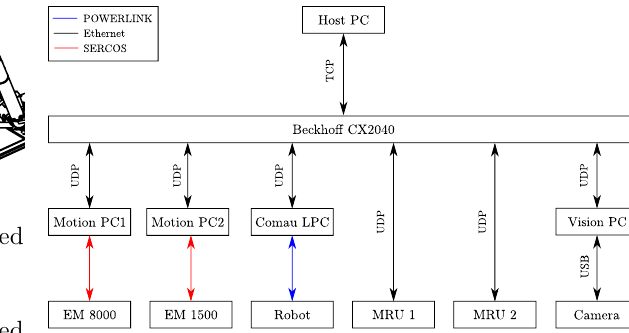
Figure 4: Communication network used to operate all the lab equipment from a common control unit (Beckhoff